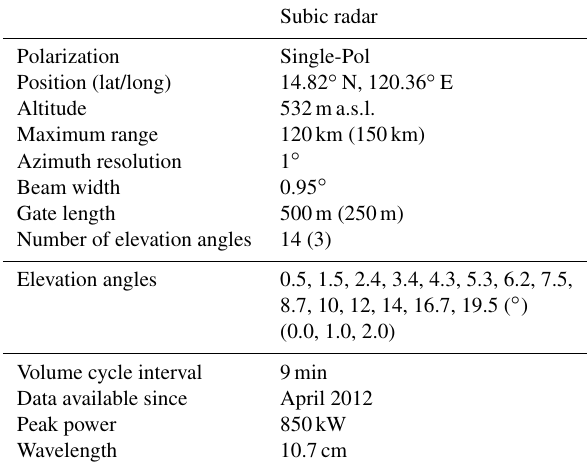
Table 1. Characteristics of the Subic radar and its volume scan strat- egy. The numbers in parentheses correspond to scans in 2015, where the scanning strategy was different due to hardware